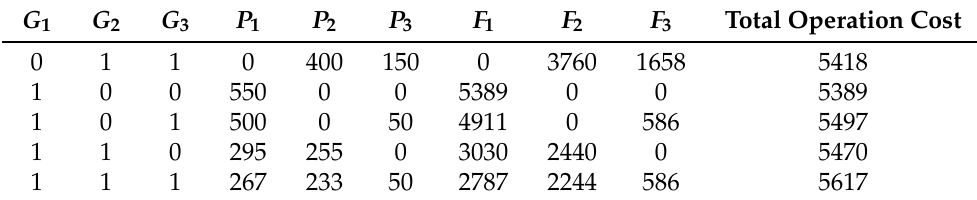
Table 1. Example of three thermal